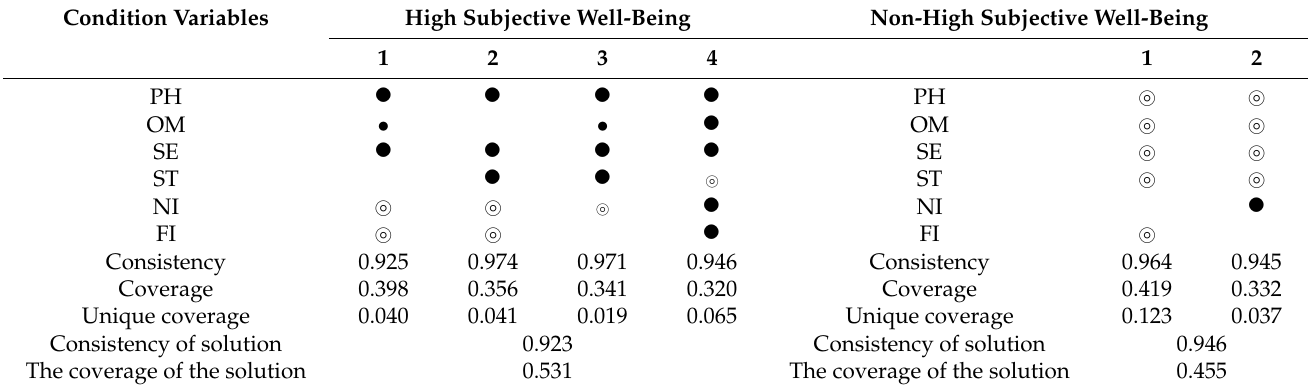
Table A1. Robustness test of non-high